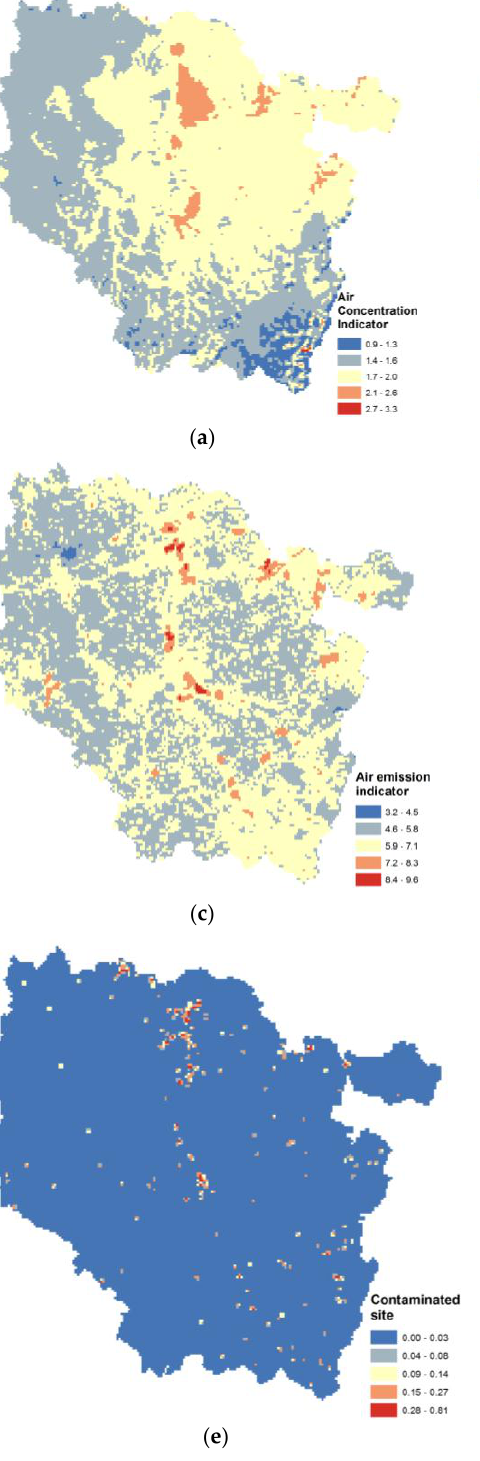
( b ) Figure 3. Maps of combined exposure variables for ( a ) air and ( b ) soil. The largest risk expressed by the composite risk indicator, obtained using the normal transformation method, corresponds to an industrial site. Spatial patterns of hotspot exposure are localized on the Lorrain furrow, reflecting the association between regional industrial and organized urban space dynamics (Figure 4).